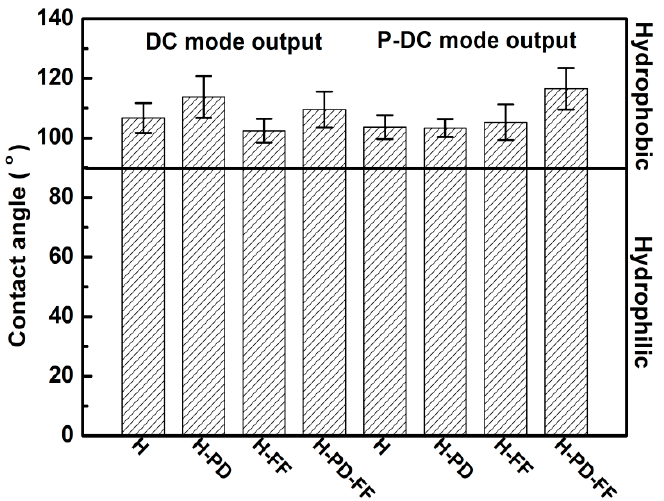
Figure 8. Water contact angle of TiN coatings created using various HiPIMS operating modes under DC or P-DC bias.